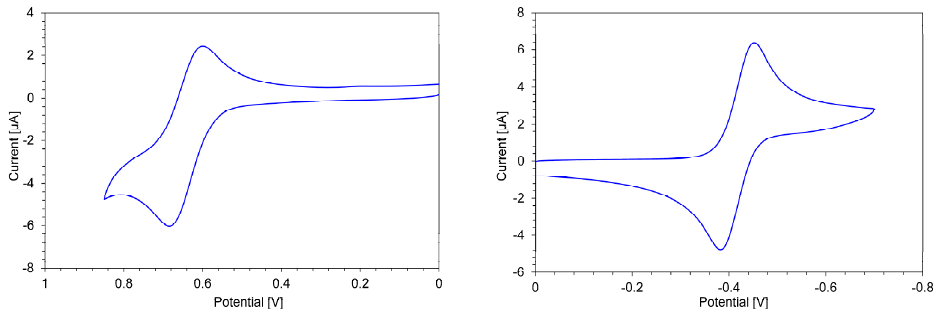
Figure 6. Cyclic voltammogram for the oxidation ( left ) and reduction ( right ) of 4b + ·PF 6 − in benzoni- trile (1 mM) containing Et 4 NClO 4 (0.1 M) as a supporting electrolyte.